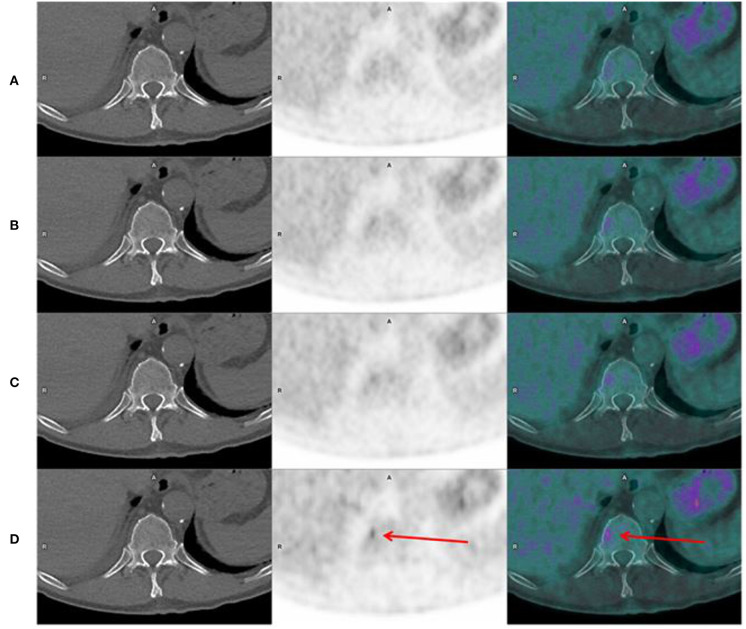
Axial CT, PET, and fusion images in a 65 years old man, showing a bone focal uptake in T11, on the “Analog-like” acquisition, which disappears when increasing acquisition time, and corresponding actually to noise [(A-D) from top to bottom, respectively, 120, 90, 60, and 30 s per bed position].